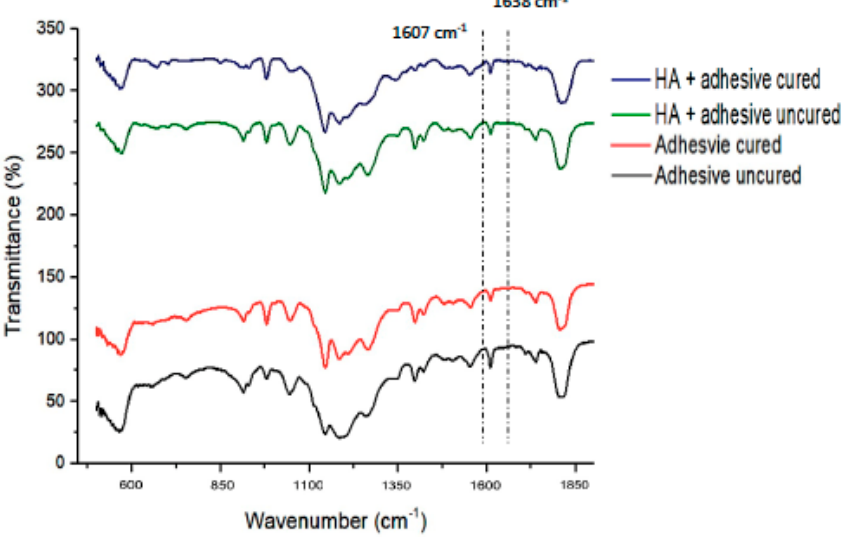
Figure 6. FTIR spectrum of uncured and cured resin adhesives containing HA nanoparticles and control (without nanoparticles). The DC was estimated from 1607 cm − 1 and 1638 cm − 1 wavenumber. Table 3. DC displayed by two adhesive groups.